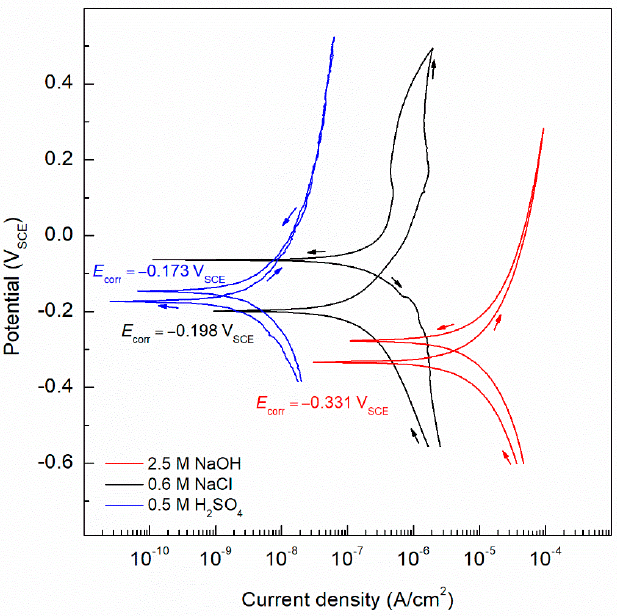
Figure 4. CPP curves for Al 10 Cr 30 Fe 25 Mn 30 Ti 5 HEA in acidic 0.5 M H 2 SO 4 (pH 0.3), neutral 0.6 M NaCl (pH 7), and alkaline 2.5 M NaOH (pH 14) electrolyte solutions. Table 3. Electrochemical parameters from the CPP curves for Al 10 Cr 30 Fe 25 Mn 30 Ti 5 HEA